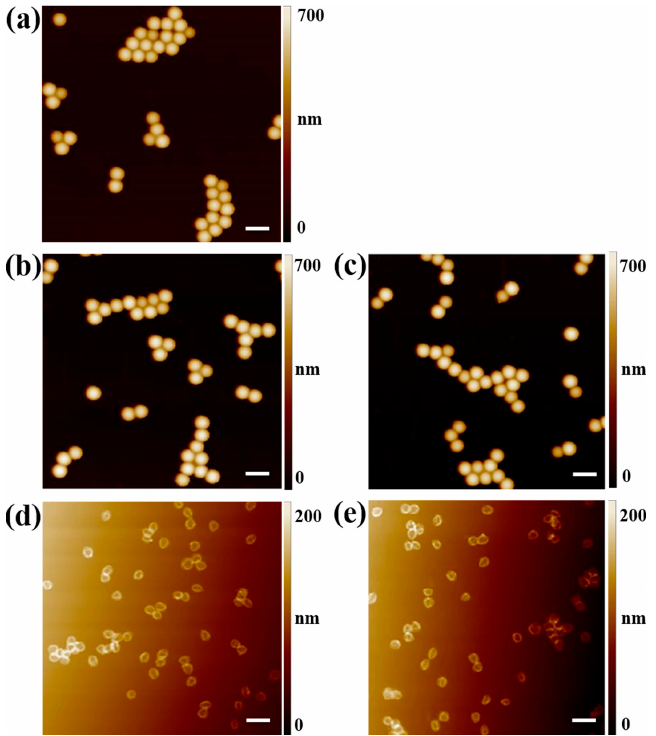
Figure 1. ( a ) AFM height images of SiO 2 -Br ( a ), SiO 2 @NBD-MIP@PEG ( b ), SiO 2 @NBD-CP@PEG ( c ), H@NBD-MIP@PEG ( d ), and H@NBD-CP@PEG ( e ). The scale bar is 1 μ m.